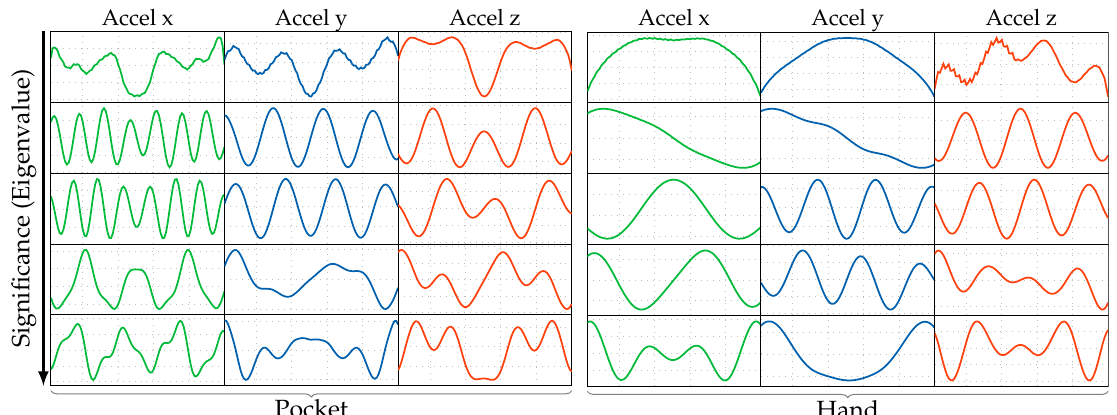
Figure 11. Shapes of the 5 most significant eigenvectors resulting from a PCA calculated on acceleration sequences 2s in length for both pocket-case and hand-case. Significance decreases from top to bottom.